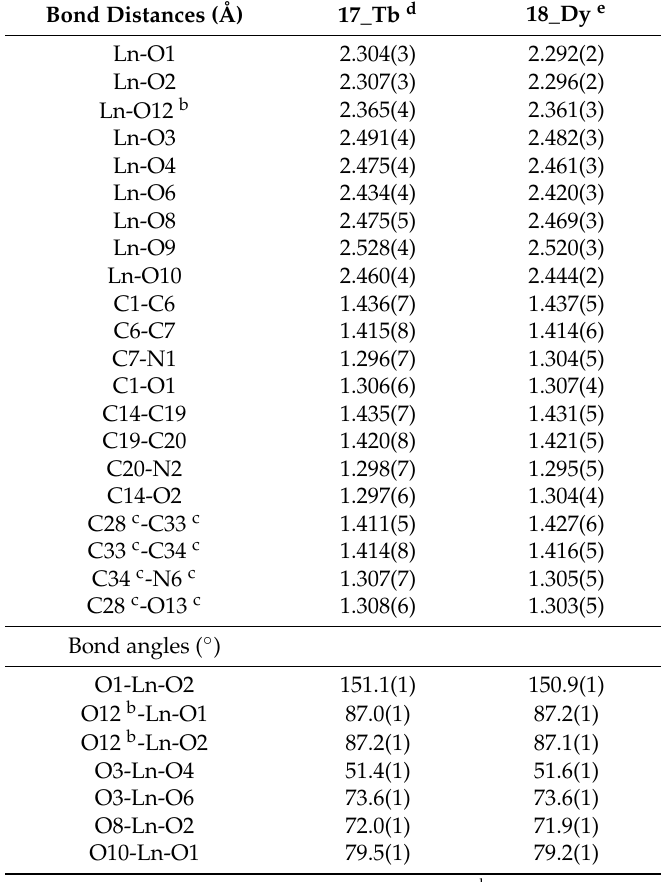
Table 3. Selected bond distances (Å) and angles ( ◦ ) for complexes 17_Tb and 18_Dy a .